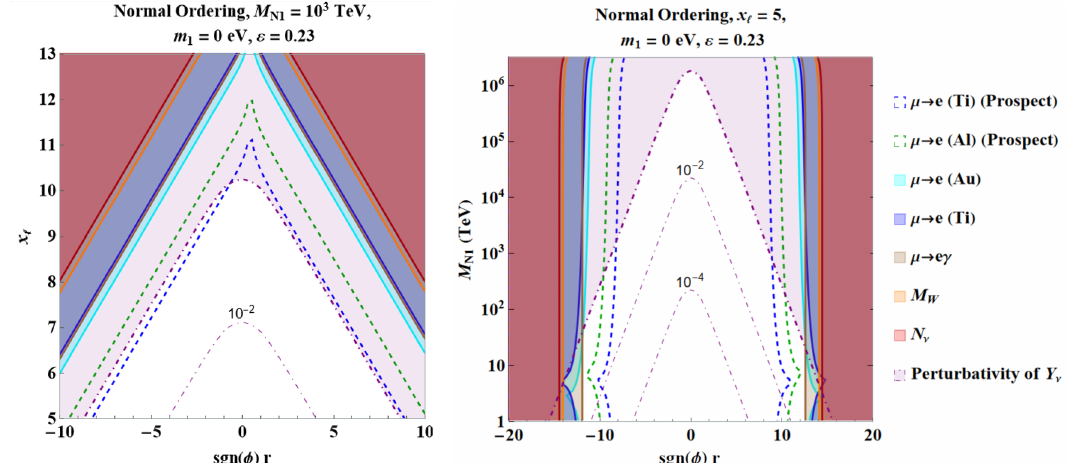
Figure 2 . Parameter space of x ‘ having fixed M N 1 = 10 3 TeV (on the left) and of M N 1 having fixed x ‘ = 5 (on the right) as a function of the parameter sgn ( φ ) r . Both plots refer to the NO case with m 1 = 0 , α 2 = α 3 = 0 , and assuming φ 1 = φ 2 = φ 3 ≡ φ . Lines and colours are explained in the